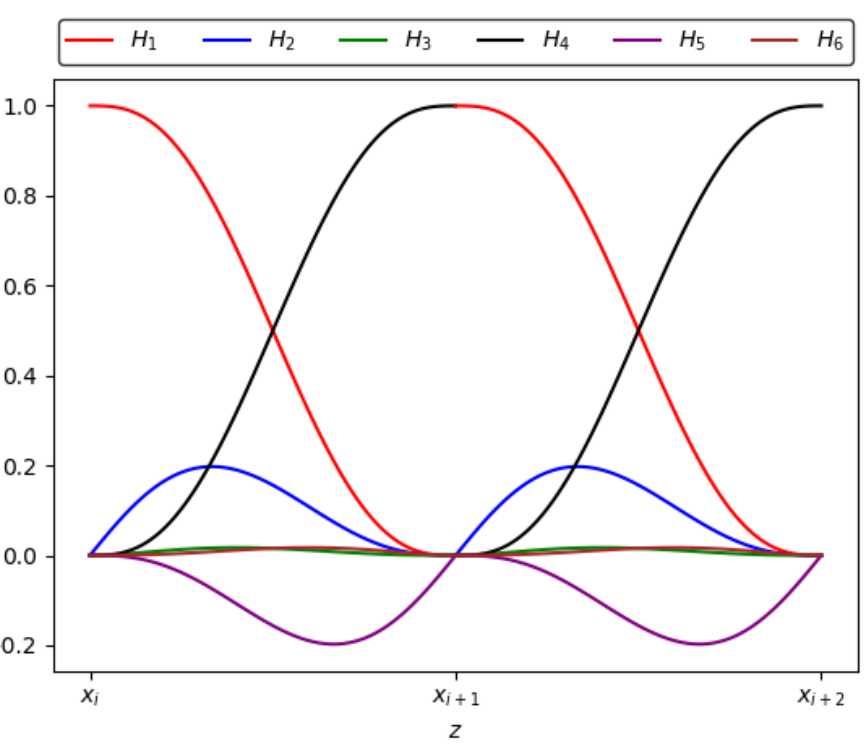
Figure 3. Basis functions on successive